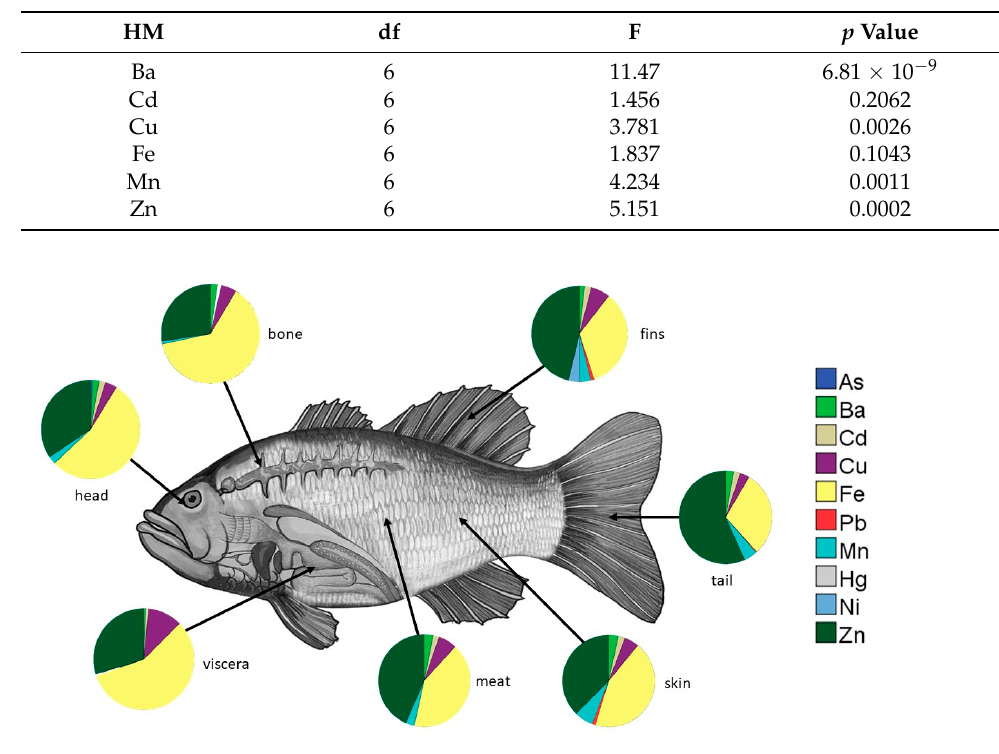
Figure 3. The share of HM concentration in each part of Tilapia spp.